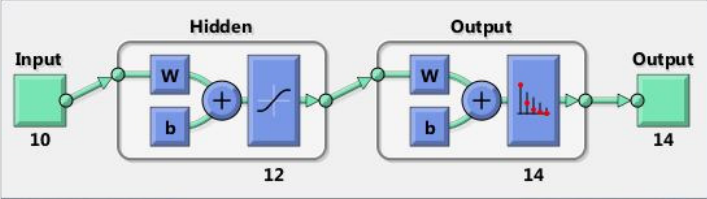
Figure 8. A two-layer perceptron for the expert